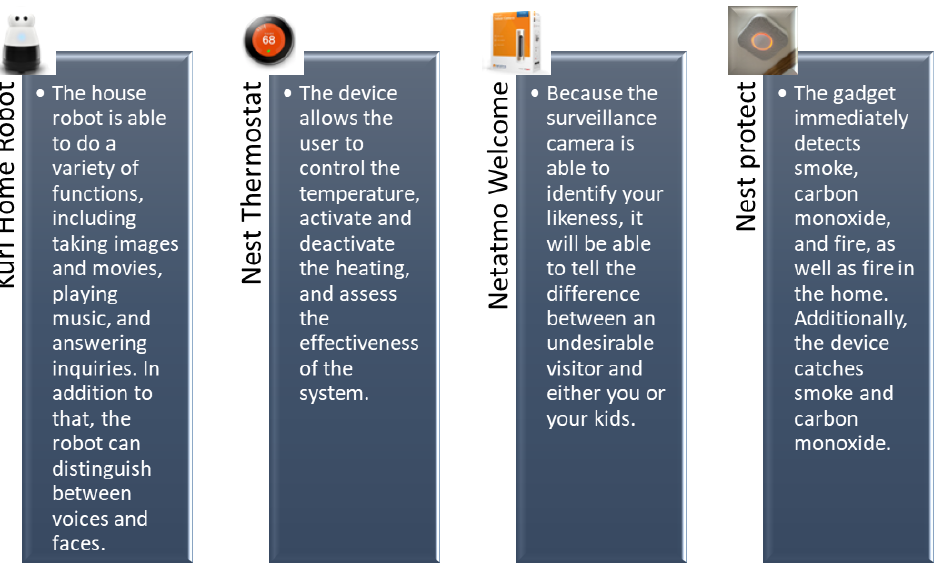
Figure 4. The AI applications on a smart home.